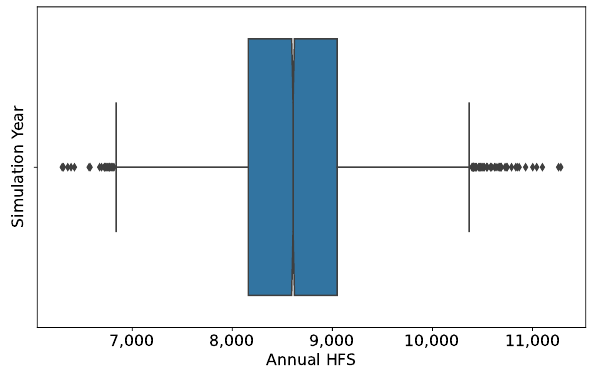
Figure 9. Annual HFS